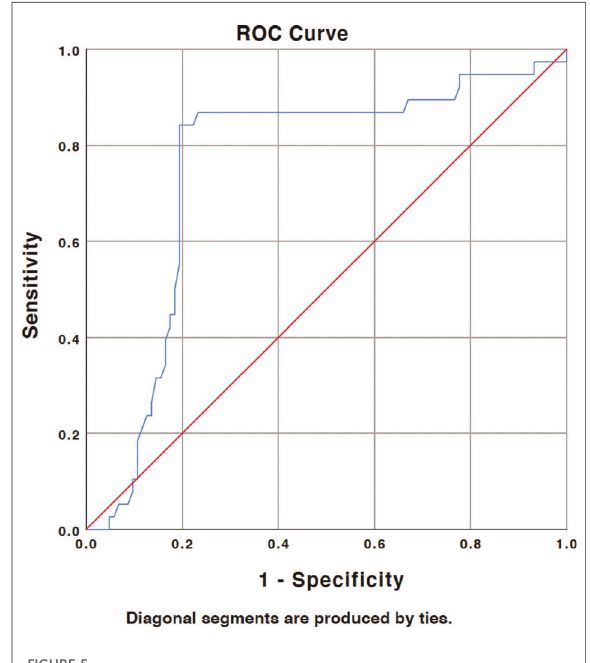
FIGURE 5 ROC analysis demonstrated that the cutoff value of T1 slope is 23.1° and AUC (area under the curve) was